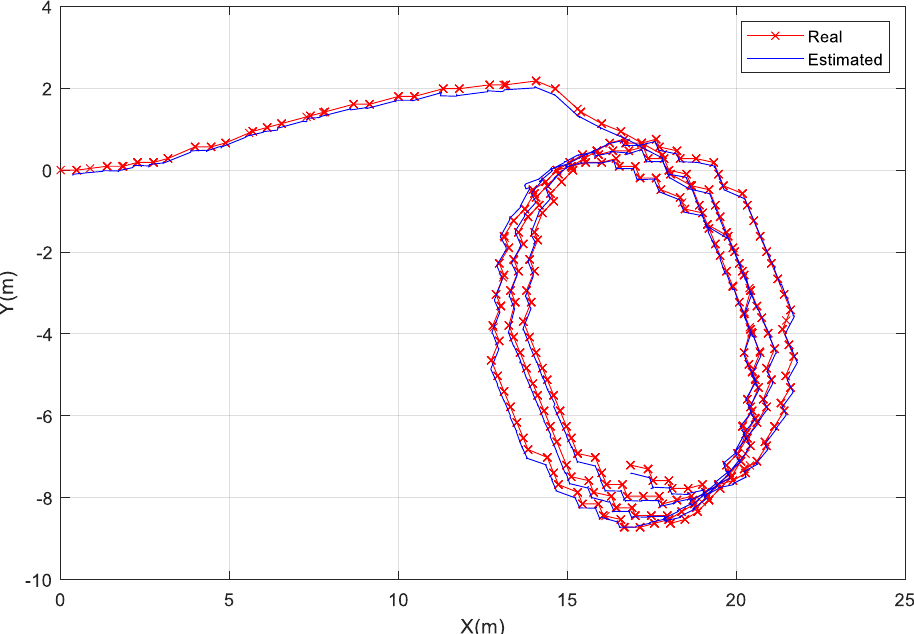
Figure 10. Experimental and estimated trajectory for data set turning 2.